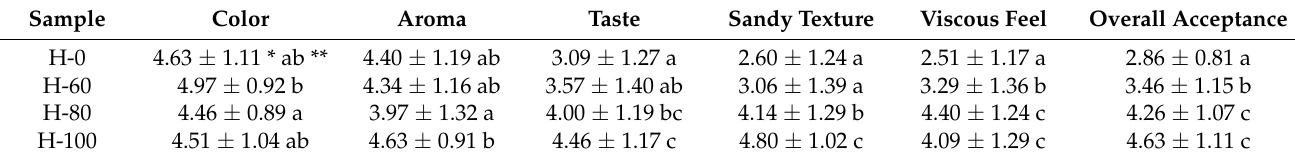
Table 4. Sensory acceptance of instant porridge prepared from native adlay flour (H-0) and pre- gelatinized adlay flours prepared at different temperatures (60 ◦ C (H-60), 80 ◦ C (H-80), and 100 ◦ C